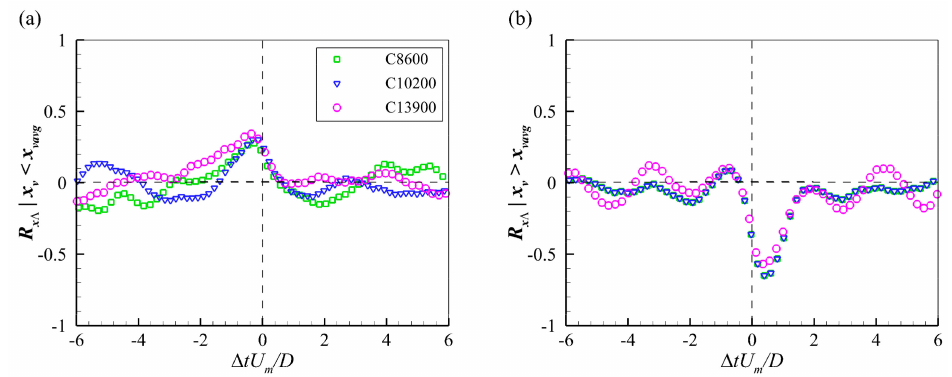
Figure 12. Conditional correlation functions between the streamwise position and swirling strength of PHVs locating at ( a ) upstream and ( b ) downstream of their time-averaged streamwise